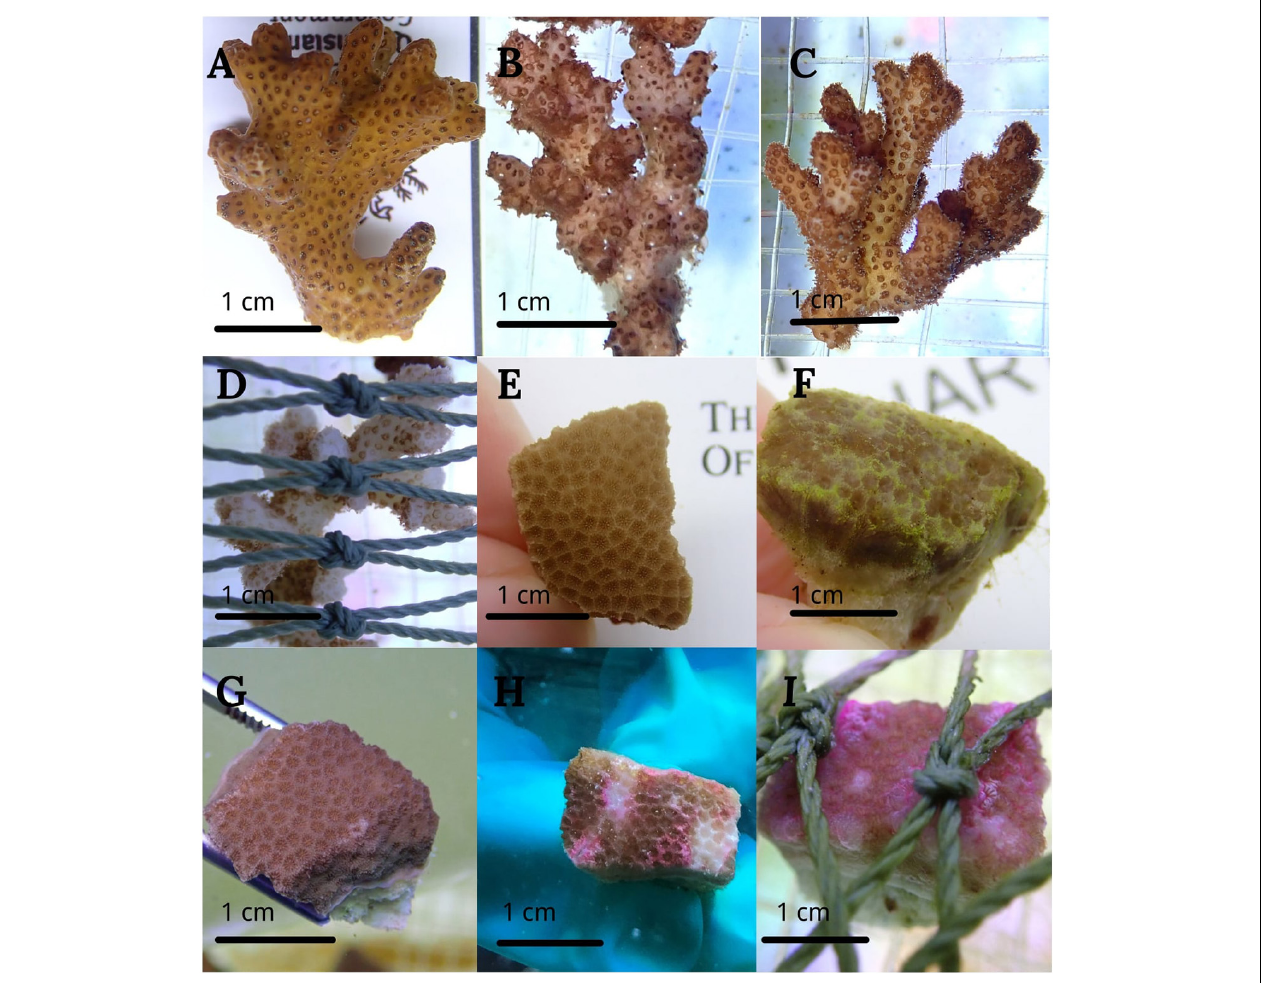
FIGURE 2 | Images of the different corals subjected to treatments for 4 weeks. P. acuta and P. lutea in control (A,E) , transparent bag (B,F) , opaque bag (C,G) , and fishing net treatments (D,H,I) .